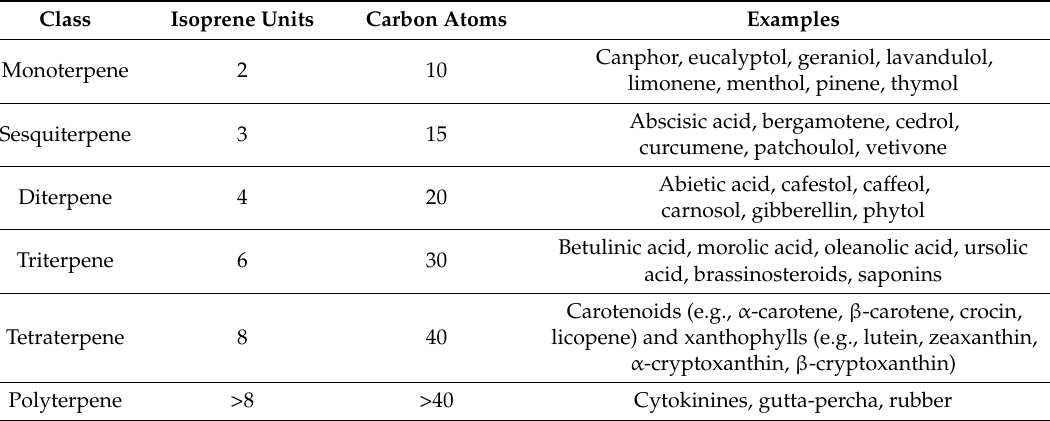
Table 2. Classification of terpenes and terpenoids on the basis of their isoprene